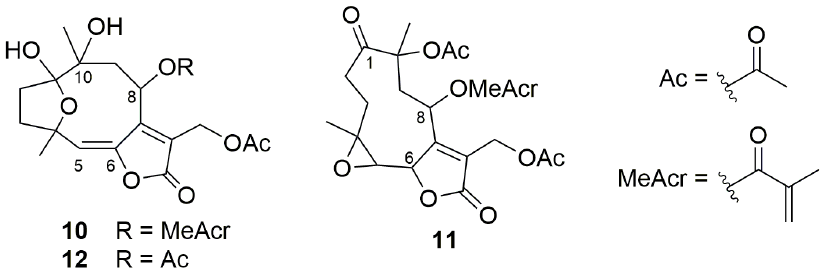
Figure 12. Structures of sesquiterpene lactones 10–12 .